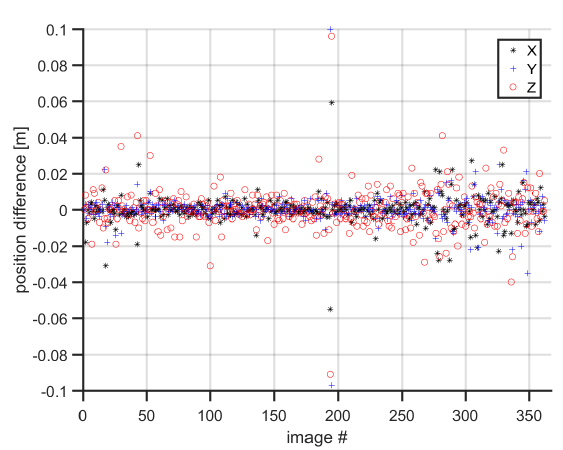
Figure 5. Differences in relative camera positions between high- end and low-cost L1 only (ambig. float) GNSS receivers.